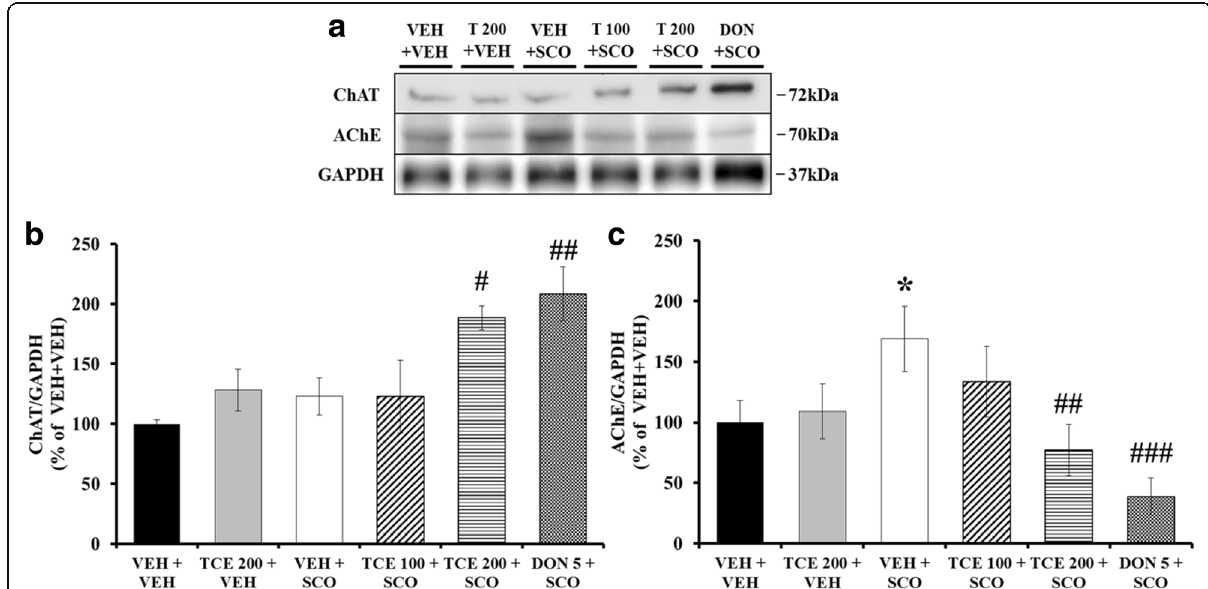
Fig. 4 Effect of TCE on hippocampal ChAT and AChE expression in the scopolamine-induced model. a Representative protein bands of ChAT and AChE. GAPDH was used as a loading control. b The quantification of ChAT expression is shown ( n = 5 per group). c The quantification of AChE expression is shown ( n = 5 per group). Bar graph is expressed as a percentage of VEH + VEH control. The data are expressed as the means ± S.E.M. * p < 0.05 compared with VEH + VEH; # p < 0.05, ## p < 0.01, ### p < 0.001 compared with VEH + SCO. VEH; vehicle, SCO; scopolamine, T;